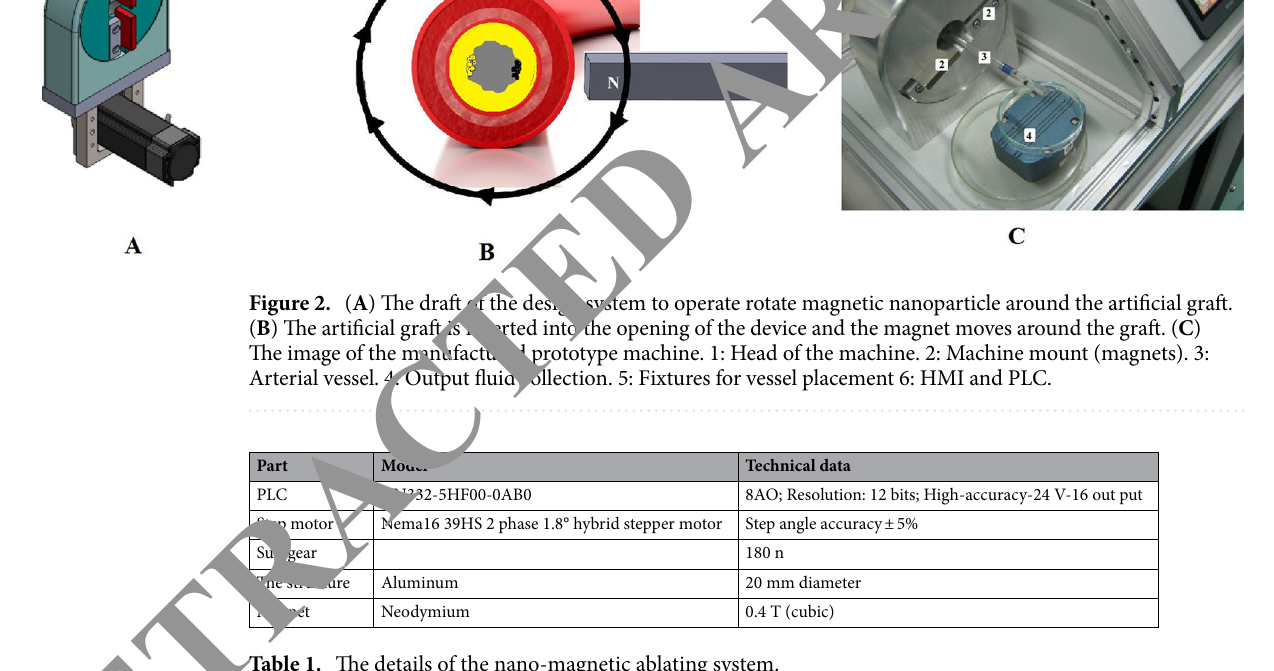
Table 1. The details of the nano-magnetic ablating